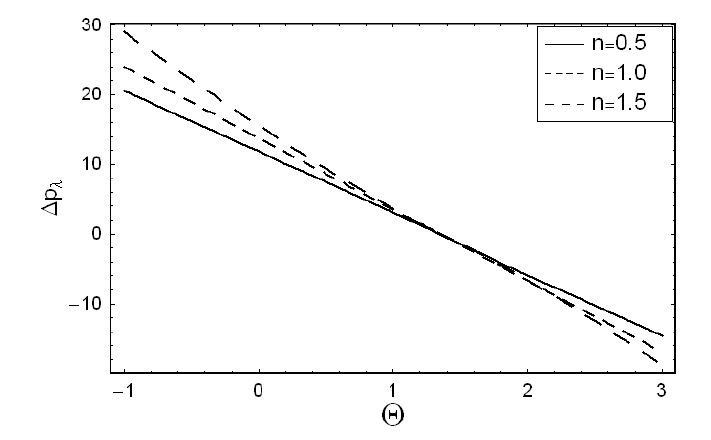
Figure 7. Variation in ∆ p λ versus Θ for n with a = 1.0, b = 0.7, d = 1.2, b ∗ = 0.2 and φ = π /4.